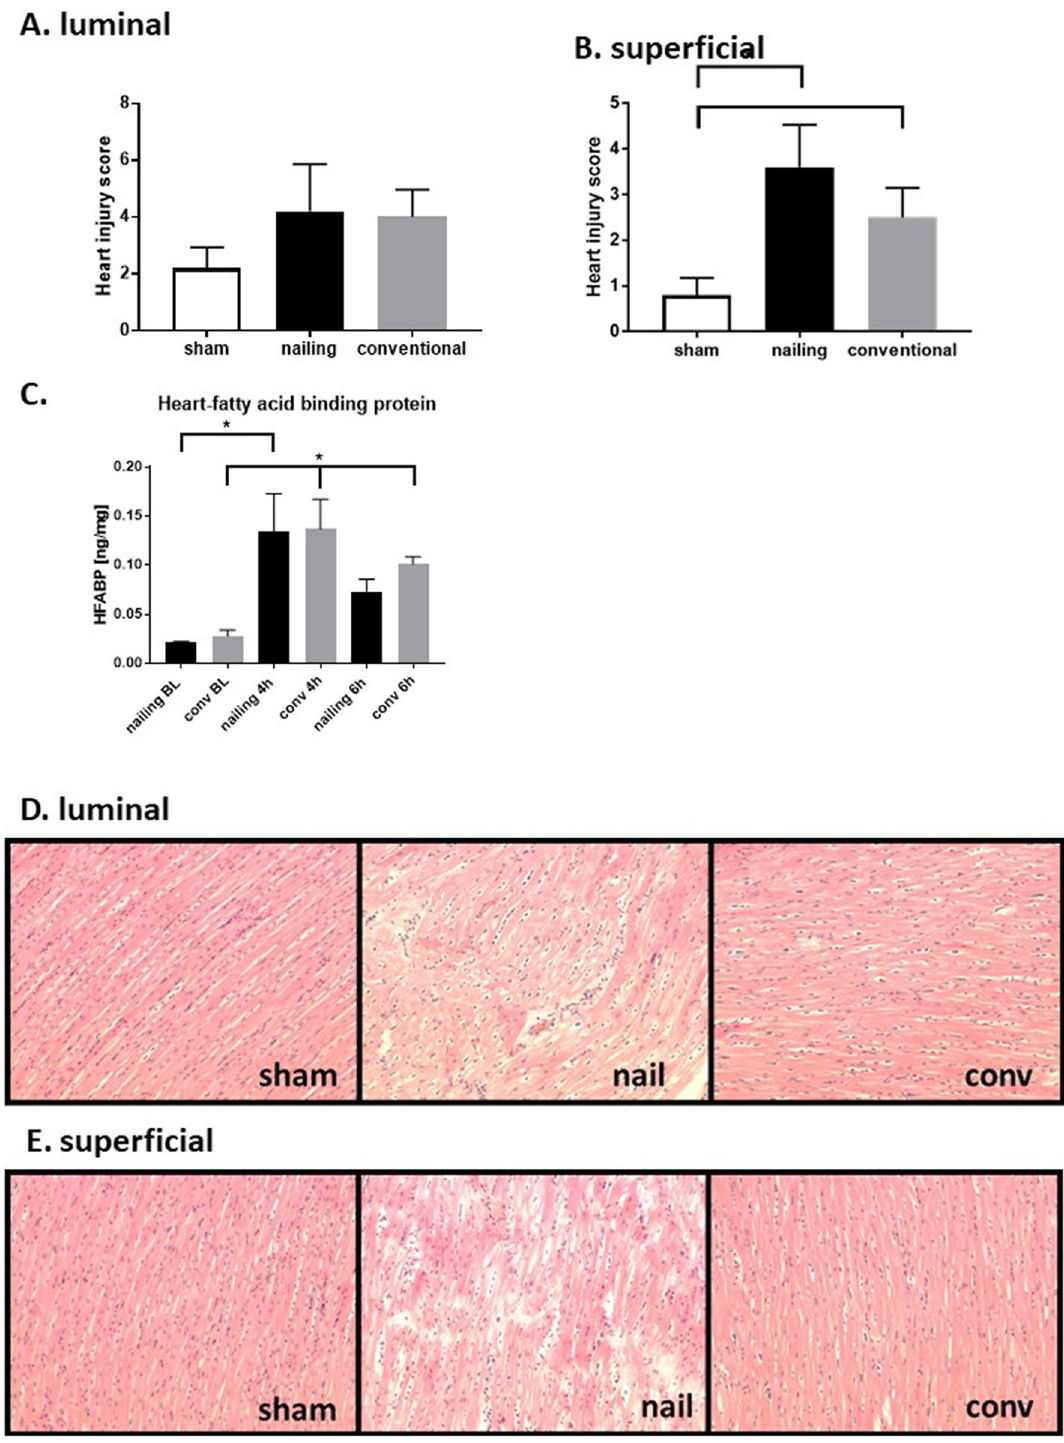
Figure 5. Cardiac damage after multiple trauma in pigs measured by echocardiography. ( A , B ) Heart injury score reflecting histomorphological sections of H.E. stained sections of the left ventricle 6 h after trauma, scored for apoptosis, contraction band necrosis, neutrophilic infiltration, intramuscular bleeding, rupture, edema and ischemia, *p < 0.05, n = 5 in each group compared to sham treated animals. ( C ) Heart-fatty acid binding protein (HFABP) in ng/ml detected in both subgroups at BL, 4 h and 6 h after multiple trauma. ( D ) Representative images of H.E: stained sections from the luminal left ventricle. ( E ) Representative Images of the superficial issue layers stained by H.E. *p < 0.05 compared to baseline, n = 5 in each